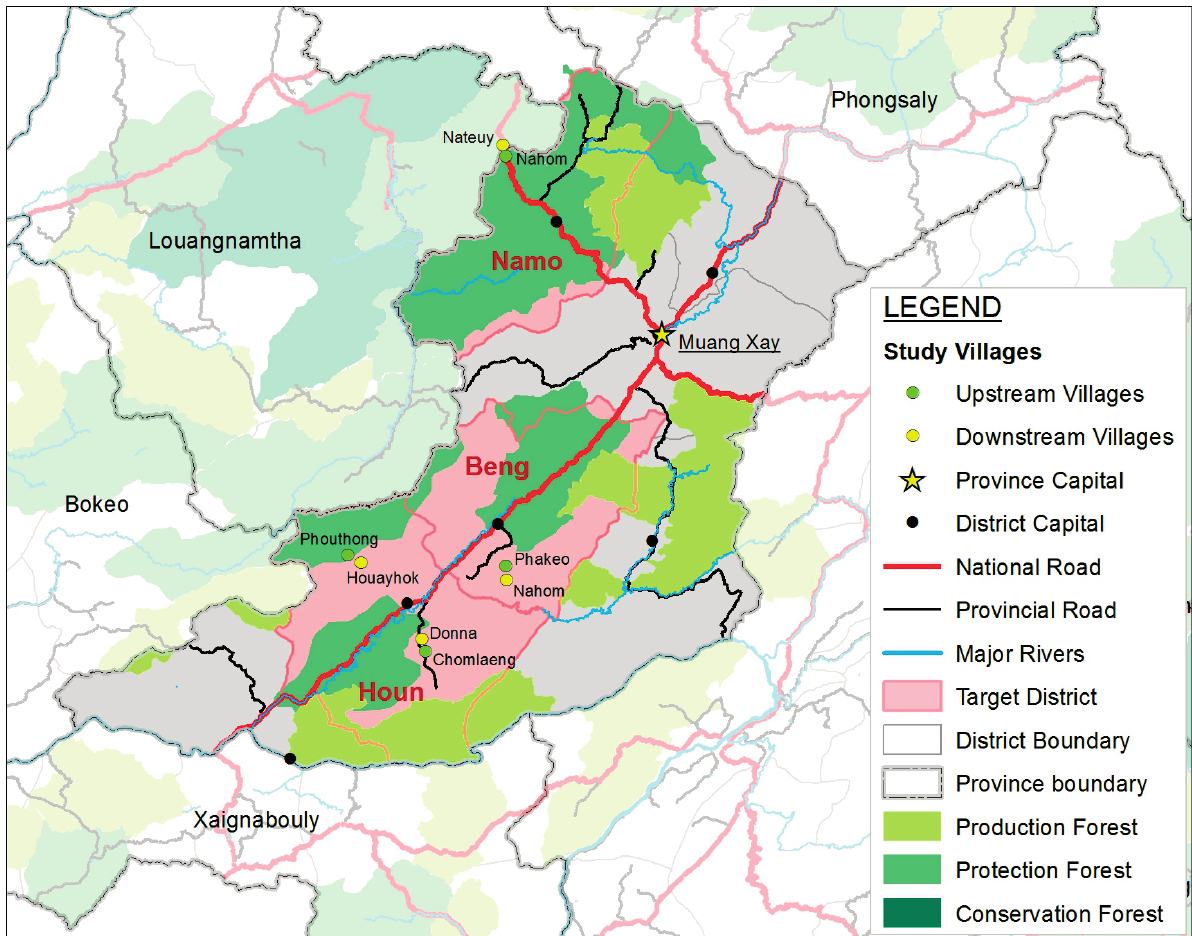
Figure 2. Areas of forests under different classifications in